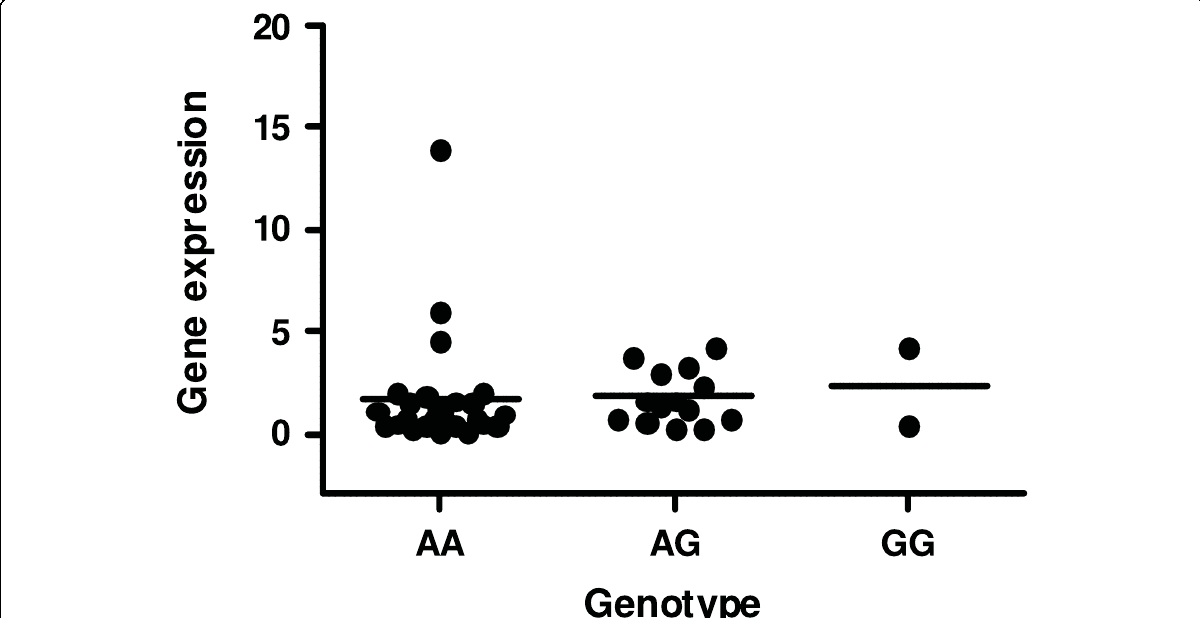
Figure 2 ESR1 alleles and expression . Abundance of estrogen receptor gene transcripts in bone samples from patients with hip fractures according to the rs1884051 genotypes (n = 26, 14 and 2). The results are expressed as arbitrary units, normalized by the housekeeping gene